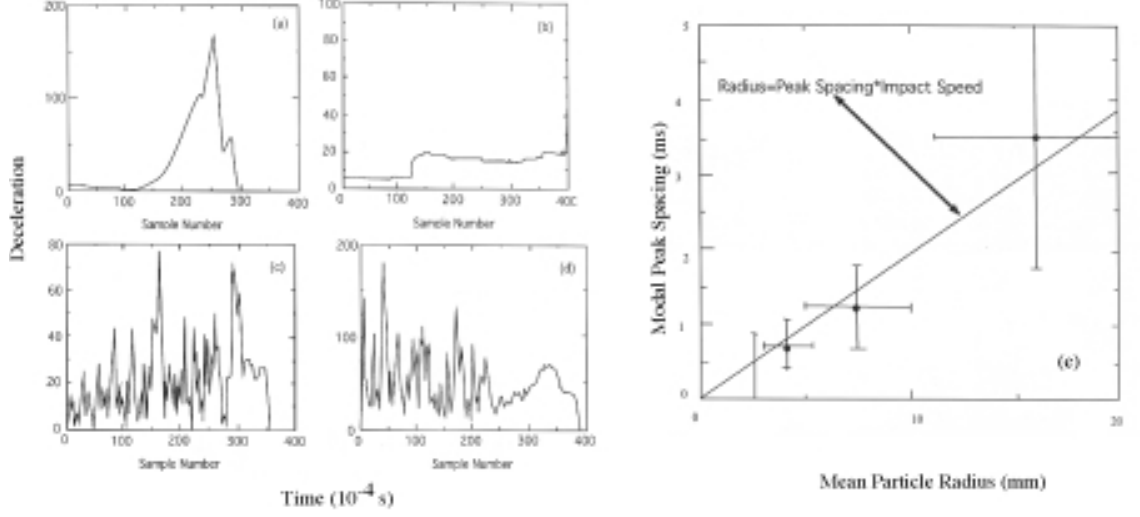
Fig. 1. Penetrator deceleration records for sand (a), Clay (b), fine gravel (8 mm) (c), medium grade gravel (15 mm) (d). The time between peaks for gravel as a function of mean particle radius (e) (Data re-plotted from [8]). of soil behavior, inertia, and probe properties are mixed during computation. Estimates of soil properties